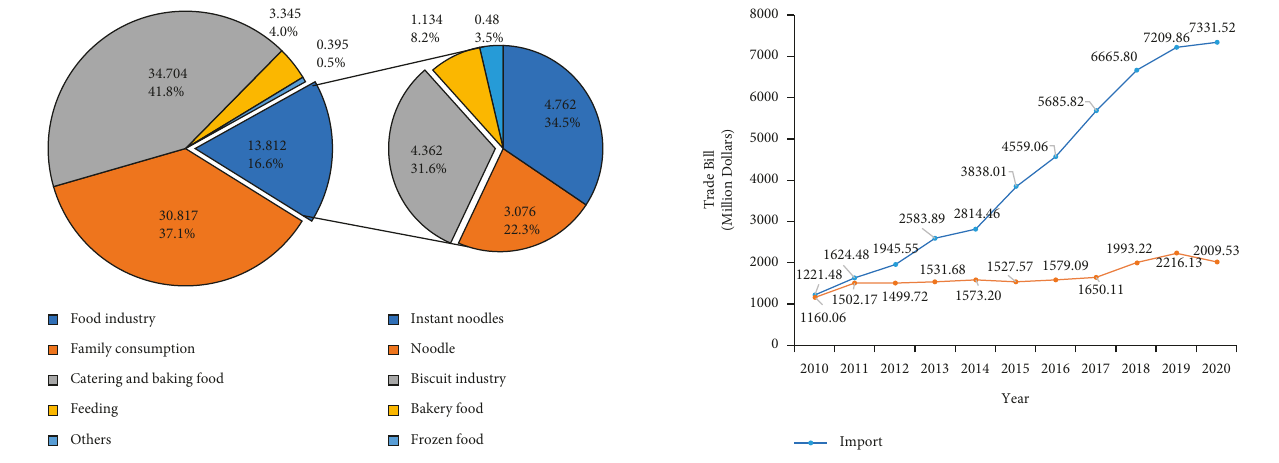
Figure 1: The consumption of China’s wheat flour in 2019 from the statistics of Ma [46]. (a) The consumption and proportion of wheat flour in different industries of China; (b) the consumption and proportion of wheat flour in Food